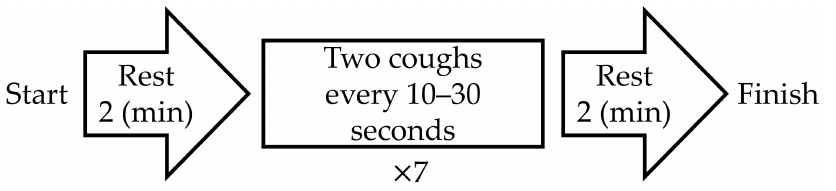
Figure 3. Protocol of experiment in this